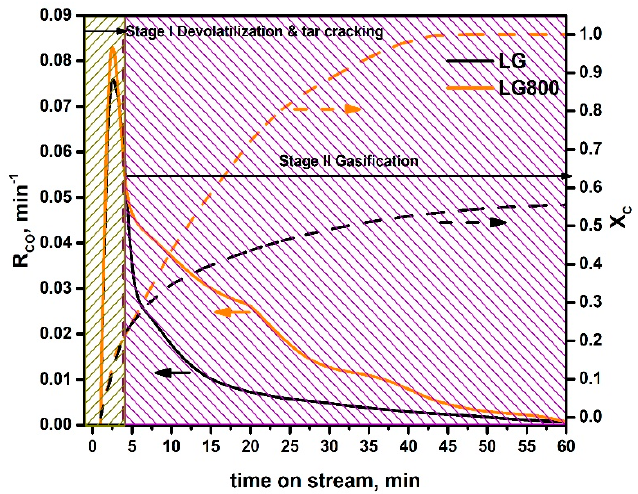
Figure 13. Instant CO production rate and the corresponding carbon conversion vs. time on stream for LG and LG800 samples under isothermal CO 2 gasification at 800 o C. Fuel: 500 mg, Flowrate: 30 cm 3 /min.